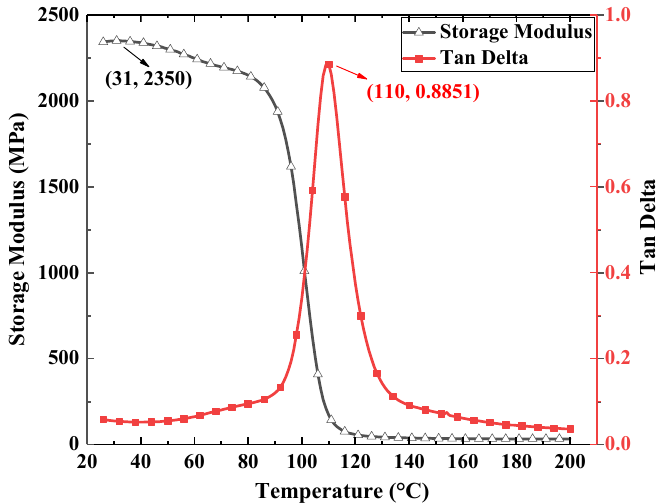
Figure 1. Dynamic thermomechanical analysis curve for the E-SMP material.